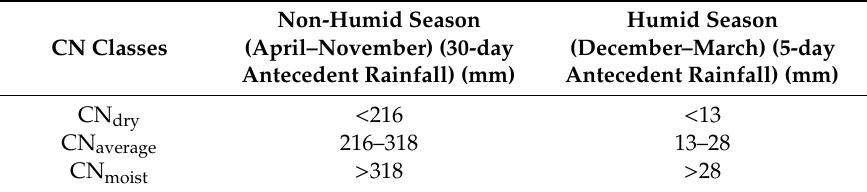
Table 2. Antecedent moisture content (AMC) conditions representative of the area under